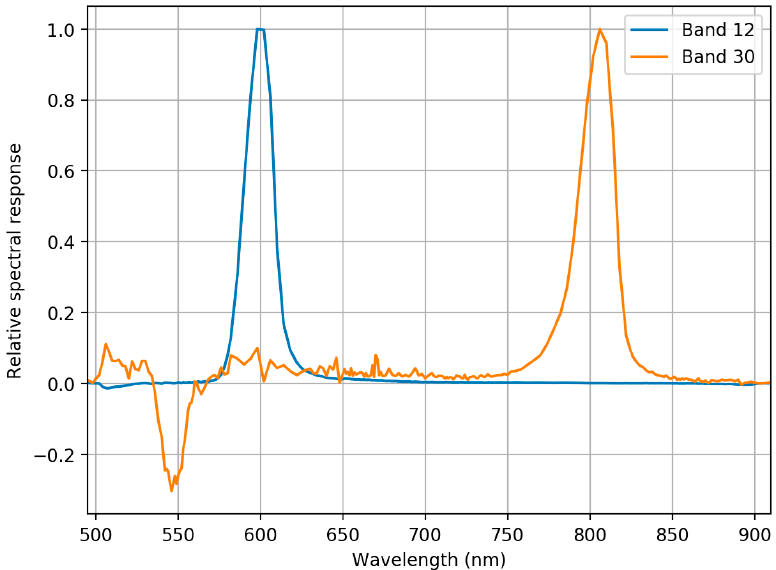
Figure 8. Example of full spectral response curves for bands 12 ( λ 0 = 599.24 nm, FWHM = 19.82 nm) and 30 ( λ 0 = 804.14 nm, FWHM = 25.13 nm). Curves are scaled so that the maximum value is 1. Sensors 2018 , 18 , x FOR PEER REVIEW